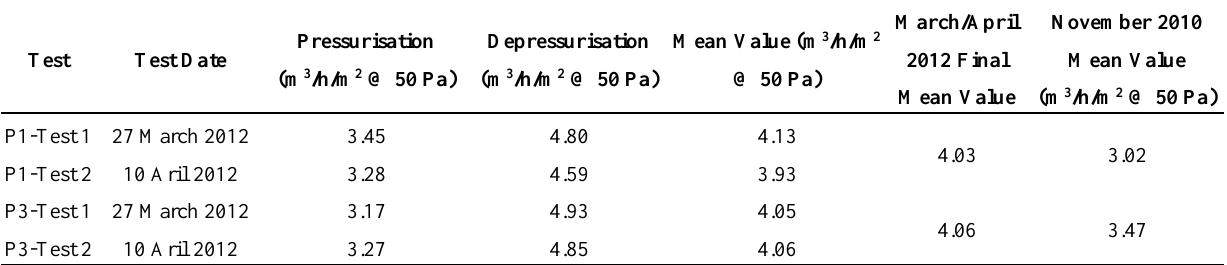
Table 1. Air permeability test